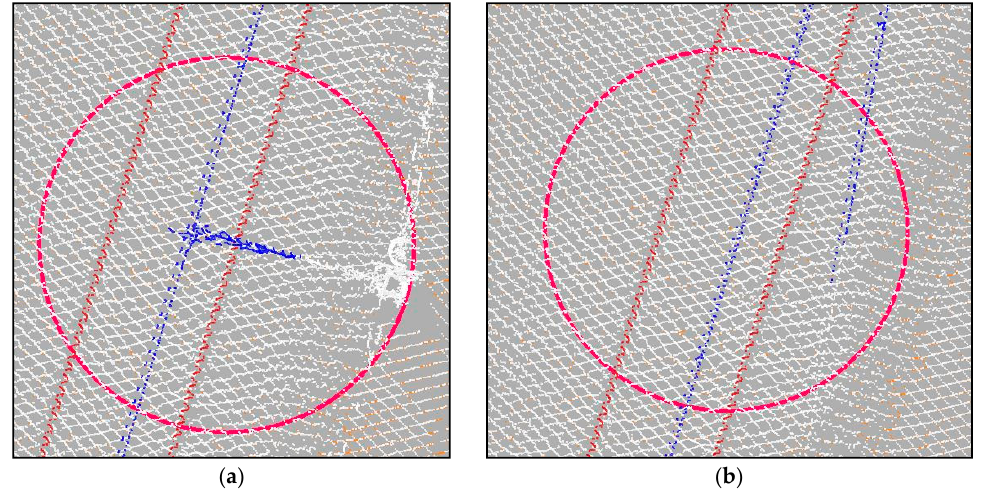
Figure 10. Sample point clouds in the place of interest and near vicinity. Increase of density caused by cantilever ( a ) and additional track ( b ). Search area limited by pink circle, catenary system in blue, rails, red, remaining points in white. red, remaining points in